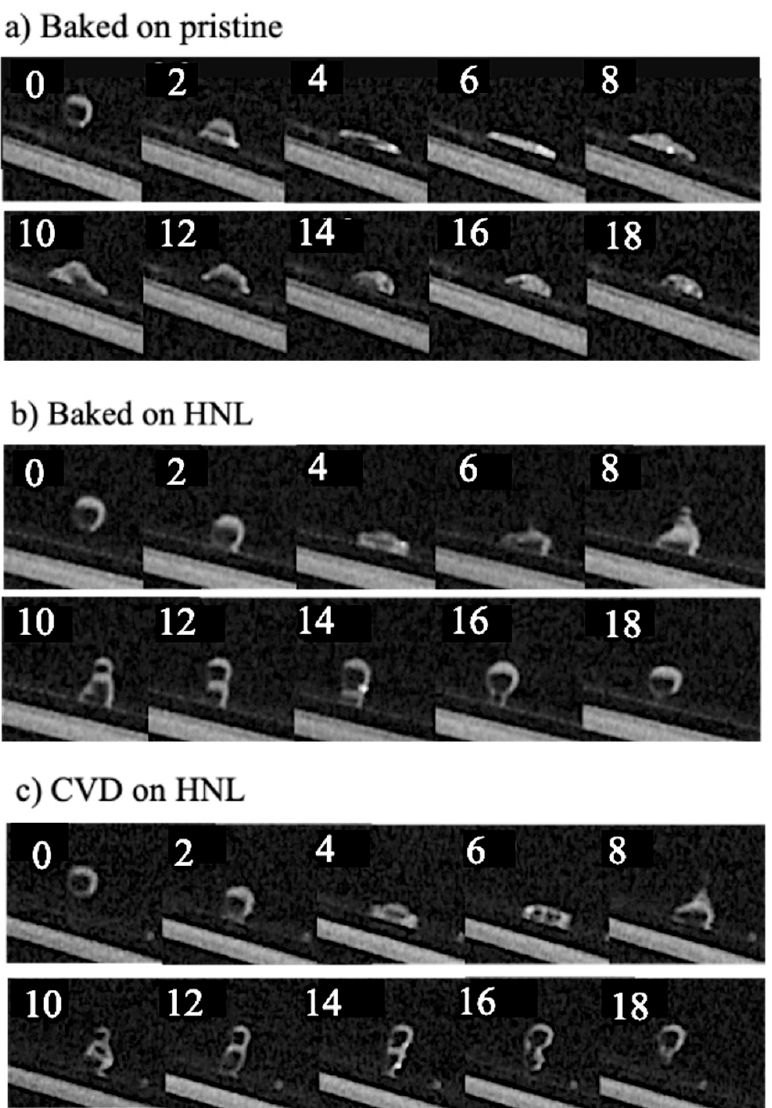
Figure 4. High-speed camera view of a water drop falling on samples ( a ) baked on the pristine substrate, ( b ) baked on the HNL, and ( c ) by CVD on HNL. The number in each frame indicates the time (in ms) elapsed from the moment of the drop.